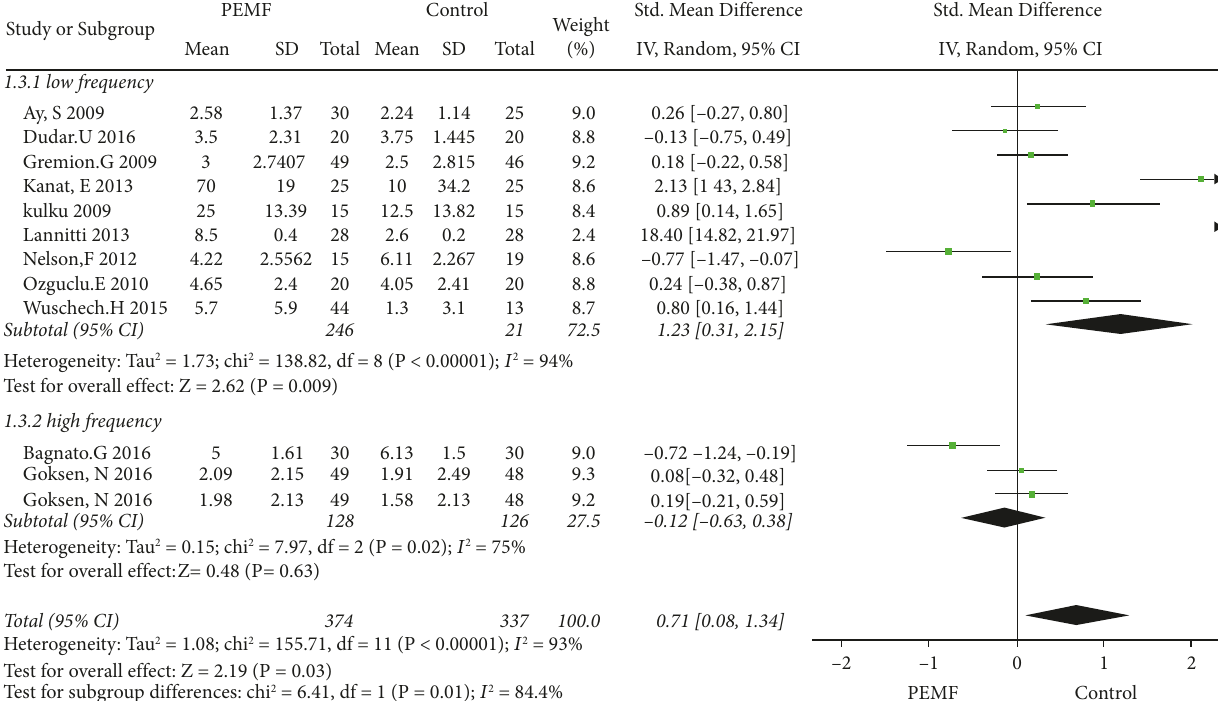
Figure 4: Forest plots representing the effect of PEMF versus control therapies in pain and subgroup analysis basing on various frequency.